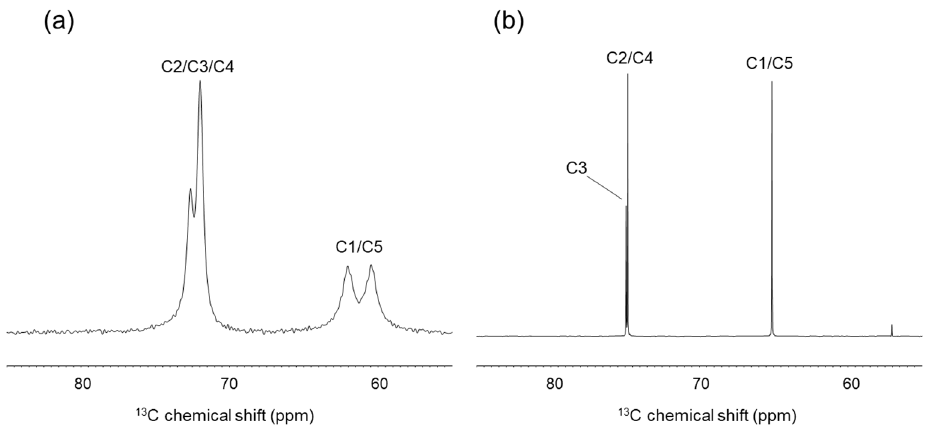
Figure 3. Comparison of solid-state and solution 13 C-NMR spectra of ribitol. ( a ) Solid-state 13 C CP-MAS -NMR spectrum of crystalline ribitol. ( b ) Solution 13 C-NMR spectrum of ribitol dissolved in D 2 O.